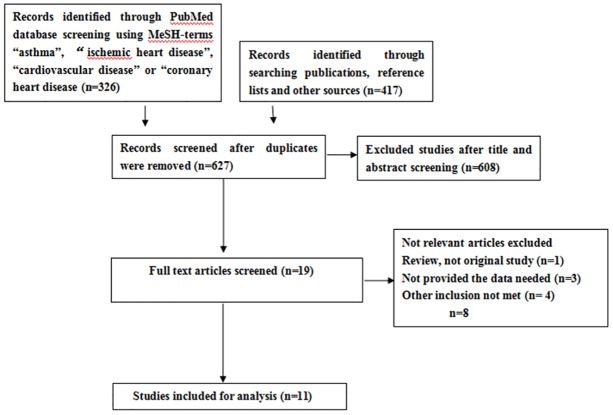
PRISMA flow diagram.